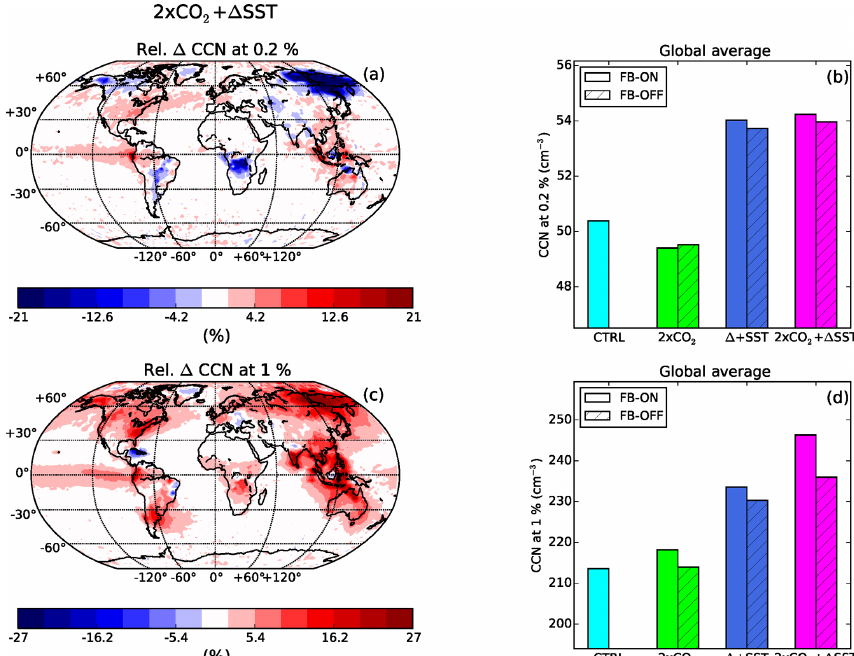
Figure 6. The relative difference between the FB-ON and FB-OFF simulations in the annual average CCN at 0.2% (a) and 1% (c) in the boundary layer, for the 2 × CO 2 + (cid:49) SST experiment. In the bar plots, the globally averaged CCN at 0.2% (b) and 1% (d) in the boundary layer are shown for the CTRL simulation as well as the three experiments (both FB-ON and FB-OFF